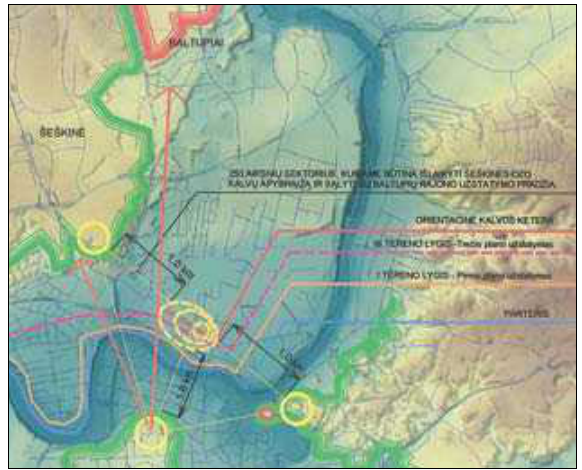
Fig. 6. Geografic logic of parameters and multi-layer landscape structure of “urban